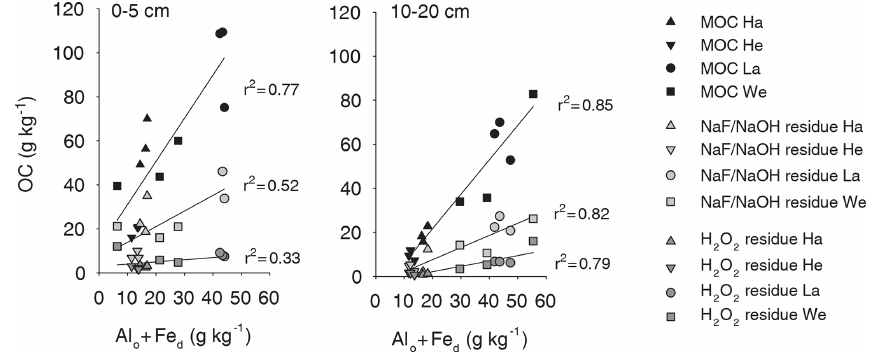
Figure 3. The OC concentrations in each fraction (bulk MOC, NaF–NaOH extraction residue, and oxidation residue) were related to the pedogenic oxide content of the sample, which is expressed as the sum of the acid oxalate-extractable Al o and dithionite-extractable Fe d .